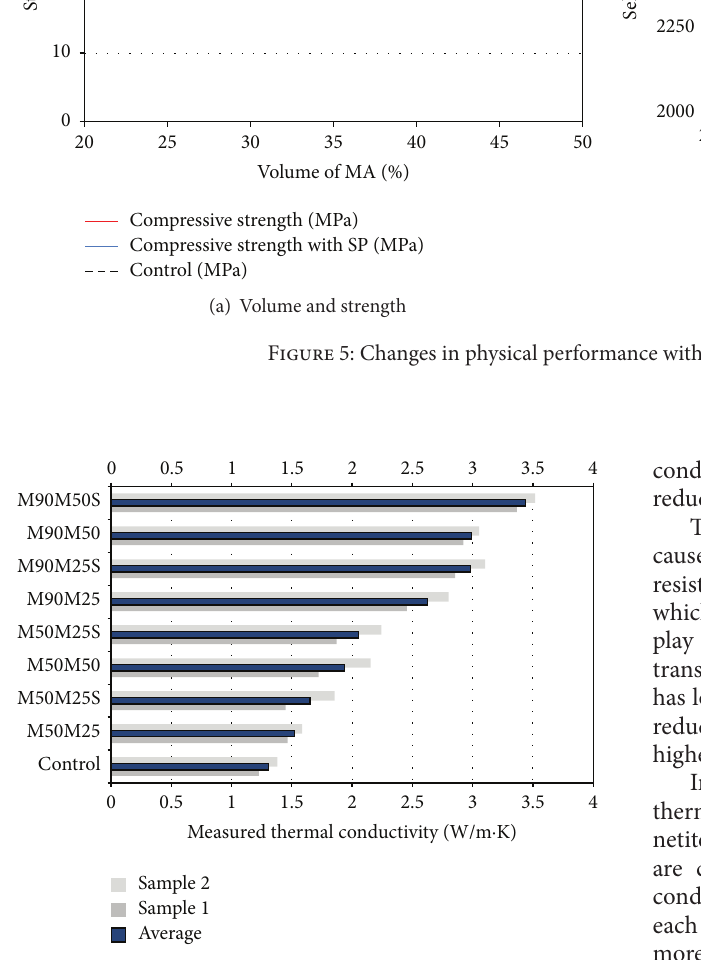
Figure 6: Measured thermal conductivity varying replacement ratios.